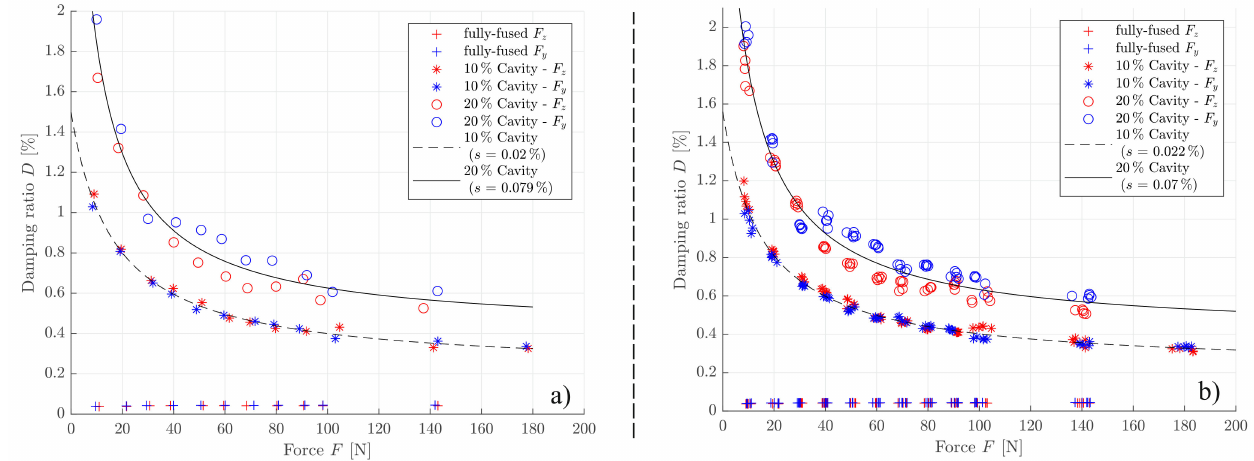
Figure 14. Force-dependent damping characteristics—1st mode, parameter 40–42, material: 1.2709, outer dimensions: 20 × 20 × 200 mm 3 , left: one hit per excitation force, right: five hits per excitation